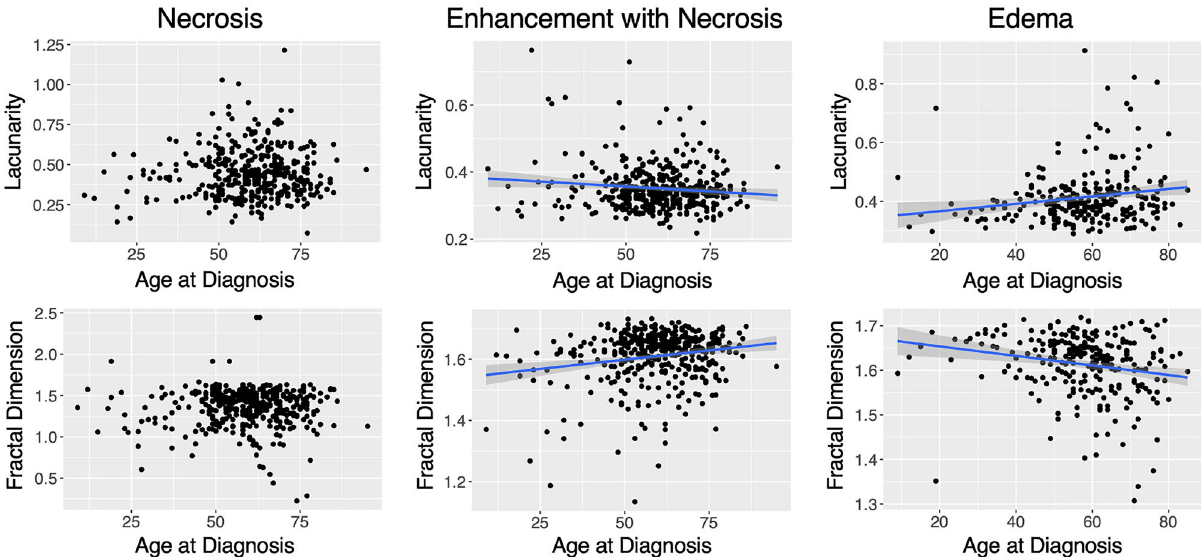
Figure 7. Significant relationships between morphology and age reversed between enhancement with necrosis and edematous regions. (Top row) We see a weak significantly negative correlation between lacunarity and age at diagnosis in enhancement with necrosis ROIs (p = 0.0217, R = − 0.11) and a weak significantly positive correlation within edema ROIs (p = 0.0035, R = 0.18). (Bottom row) We see weak significant relationships between fractal dimension and age at diagnosis within enhancement with necrosis (p < 0.001, R = 0.19) and edema ROIs (p < 0.001, R = − 0.21), respectively. Fractal dimension of enhancement with necrosis is positively correlated with age at diagnosis whereas the fractal dimension of edema ROIs has a negative correlation. Trend lines are shown for significant